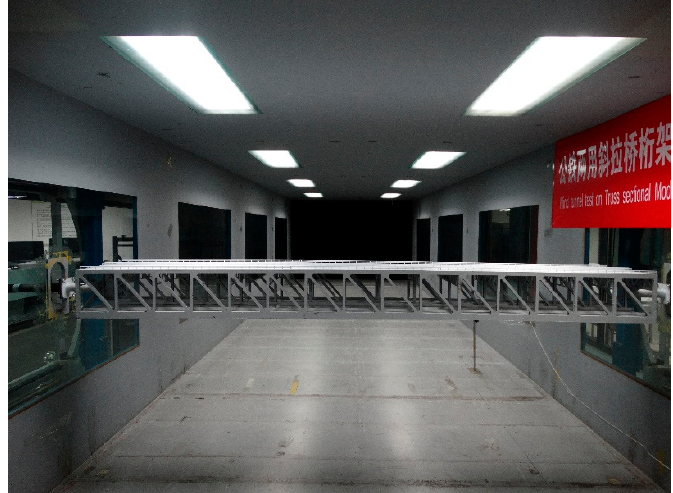
Figure 2. The segment model in the wind tunnel.